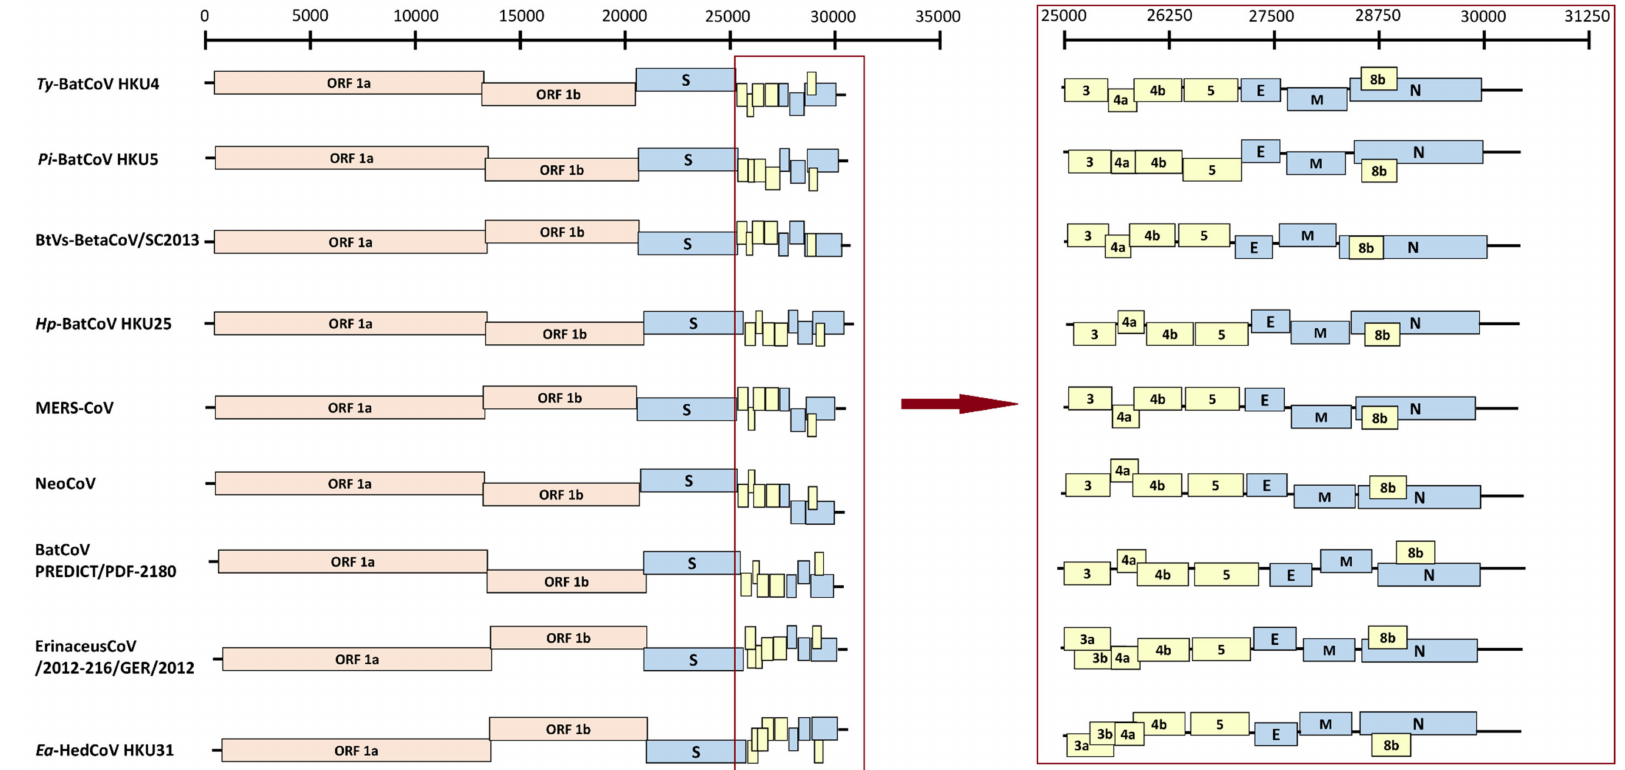
Figure 2. Comparison of genome organizations of Ea -HedCoV HKU31 with other members of Merbecovirus , including MERS-CoV, BtVs-BetaCoV SC2013, Ty -BatCoV HKU4, Pi -BatCoV HKU5, Hp -BatCoV HKU25, BatCoV PREDICT / PDF-2180, Erinaceus CoV / 2012-216 / GER / 2012 and NeoCoV. Structural proteins such as spike (S), envelope (E), membrane (M) and nucleocapsid (N) are displayed in blue boxes, while accessory proteins are displayed in yellow boxes with numbering 3-5 and 8b. ORF1a and ORF1b are represented by pink